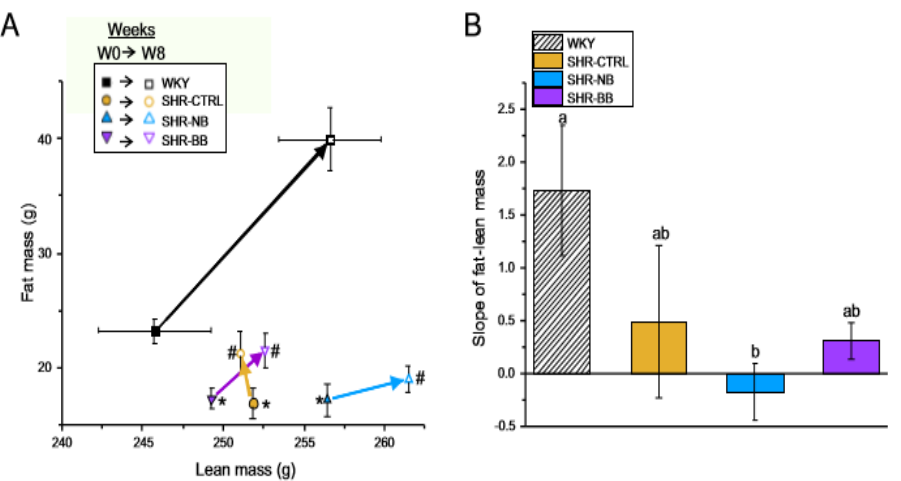
Figure 1. Phase 1: Whole body fat mass and lean mass. ( A ) Whole body fat mass-lean mass relationship at baseline compared to week 8; ( B ) Slope of the whole body fat mass-lean mass relationship. Measurements of fat mass and lean mass were obtained in vivo using an EchoMRI whole body quantitative magnetic resonance instrument and plotted with fat mass on the Y axis and lean mass on the X axis with closed symbols for baseline and open symbols for week 8. In Panel A, arrows between time points indicate direction of change from baseline to week 8. Data are expressed as mean ± SEM ( n = 9–10 / group); SEM bars for lean mass are too small to be visible in the figure. *, fat mass significantly di ff erent ( p < 0.05) compared to WKY at baseline; #, fat mass significantly di ff erent ( p < 0.05) compared to WKY at week 8. In Panel B, columns with di ff erent letters are significantly di ff erent ( p < 0.05). Abbreviations: BB, black bean diet; CTRL, bean-free control diet; NB, navy bean diet; SHR, spontaneously hypertensive rat; W0, Week 0 (baseline); W8, Week 8; WKY, Wistar Kyoto. Table 3. Phase 1: Hemodynamic properties and arterial sti ff ness. WKY SHR Control Navy Bean Black